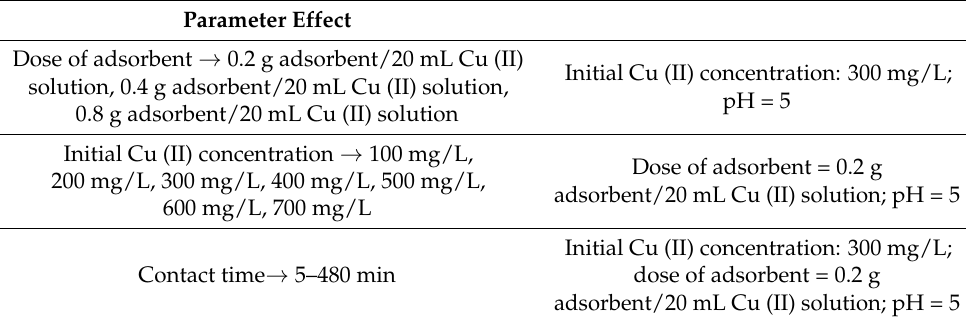
Table 1. Adsorption study